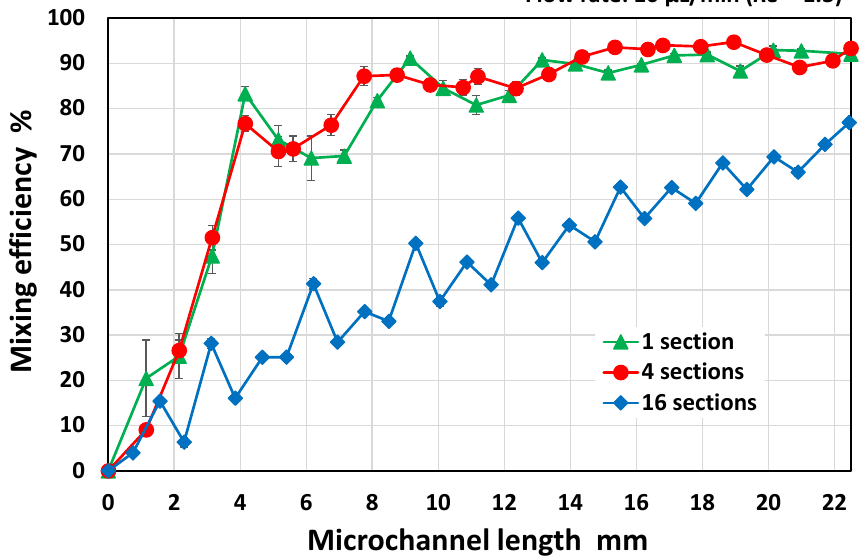
Figure 5. Experimental results showing the mixing efficiencies of three different types of asymmetric micromixers (M3) with different numbers of mixing units for a single set at a total flow rate of 10 µL/min ( Re = 1.3). For comparison, the mixing efficiencies of the asymmetric mixers with four sets of twenty-five mixing units and a single set of one hundred mixing units are also plotted in the graph based on the data shown in Figure 3 and Section 3.4, respectively.